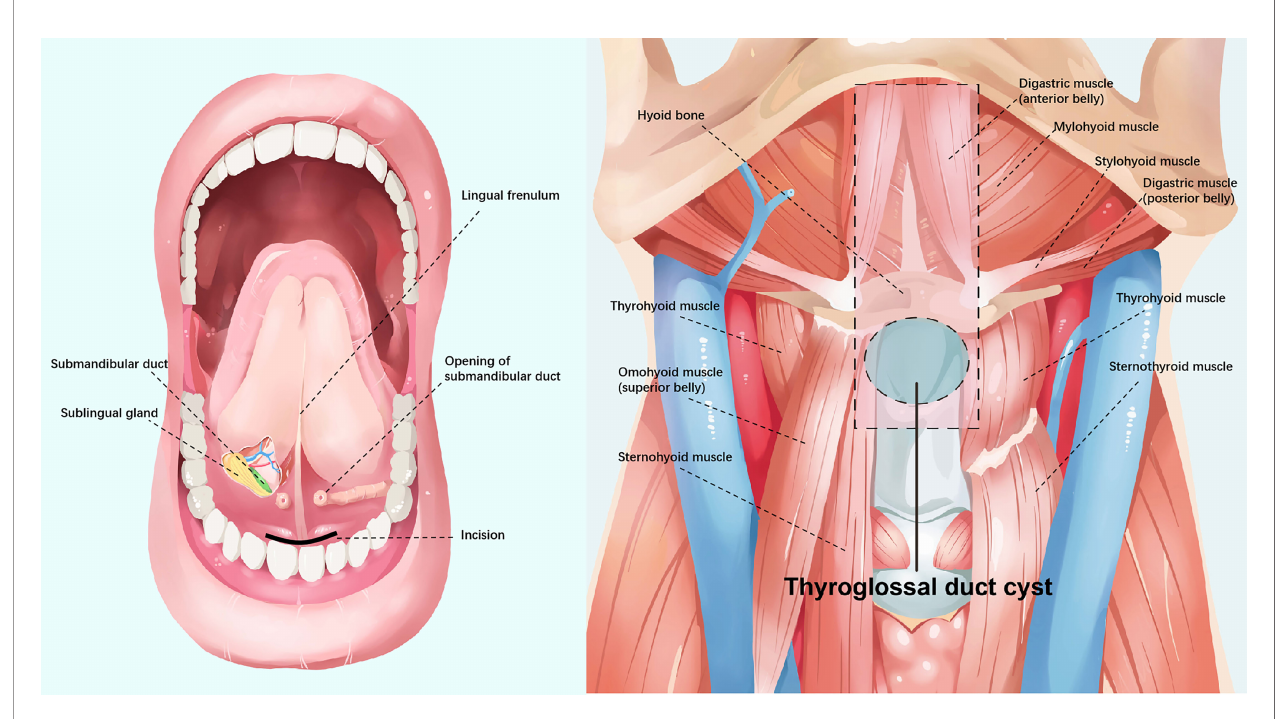
FIGURE 1 | Illustration of